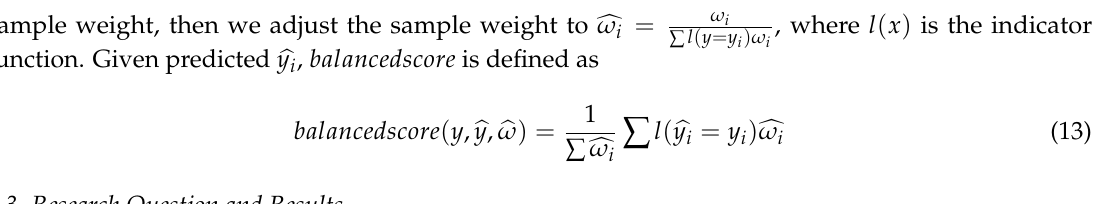
Table 3. Selection of classifiers and parameters.